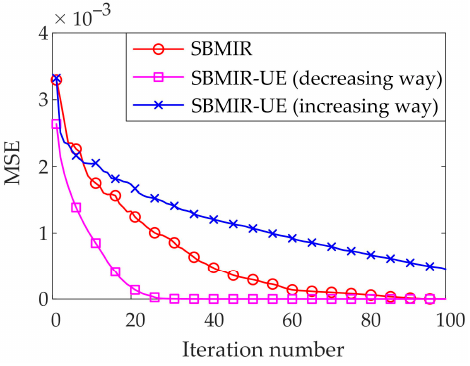
Figure 8. Plots of mean square error (MSE) of SBMIR and SBMIR-UE using the decreasing interval distribution and the increasing interval distribution, respectively.